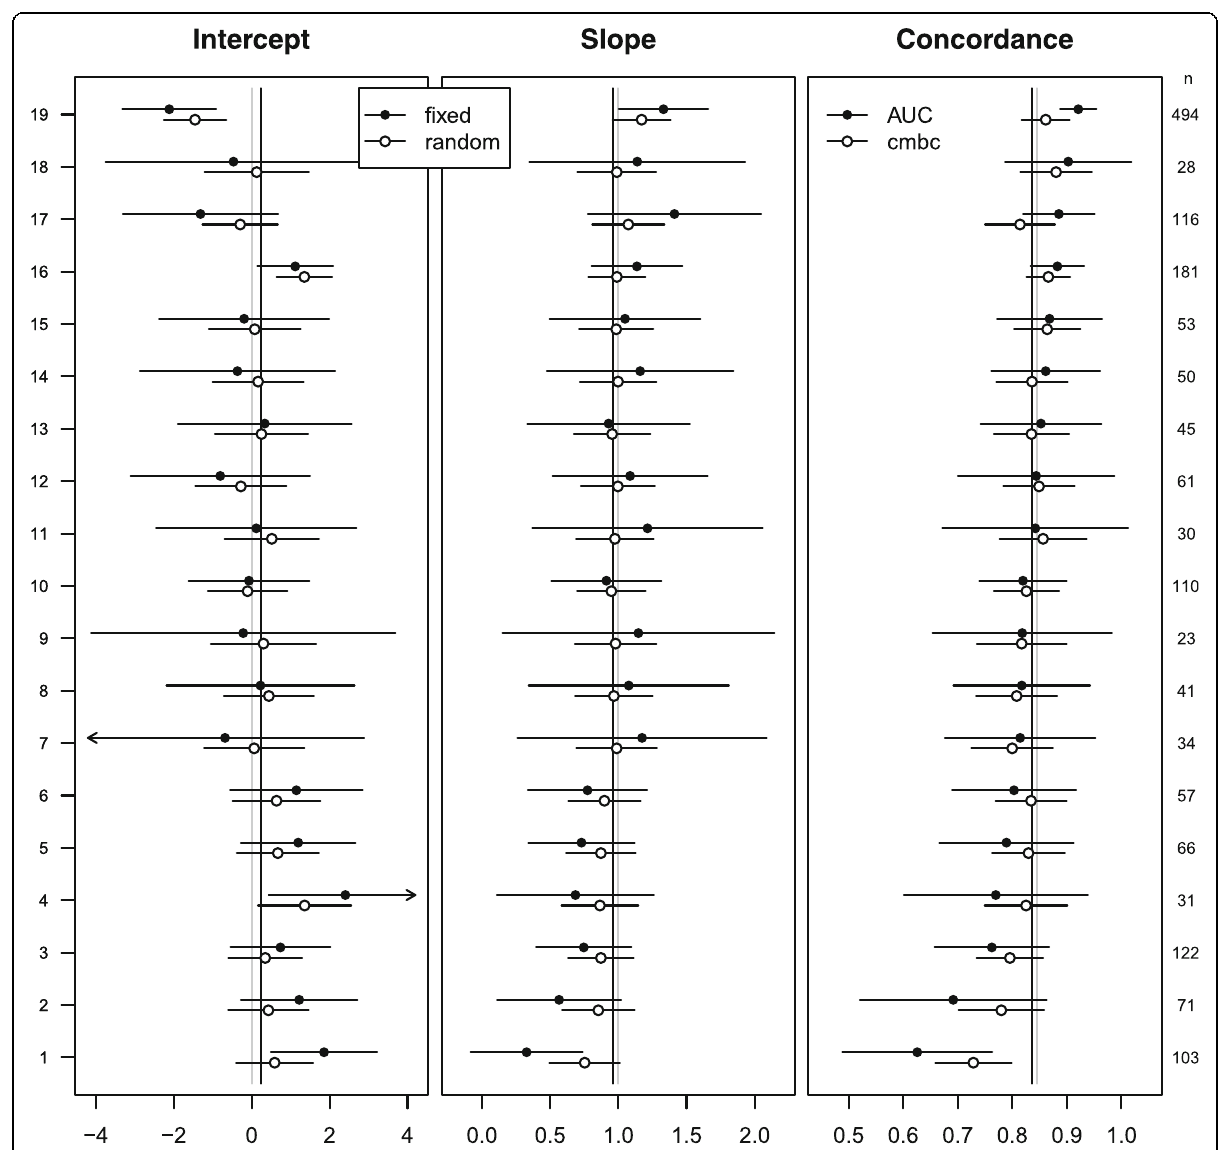
Fig. 1 Performance measures at internal validation across 19 centers of the CRASH trial. Closed dots represent fixed effect intercept estimates; fixed effect slope estimates; and c-indexes in the first, second, and third panel, respectively. Open dots represent random effects intercept estimates, random effects slope estimates, and calibrated model-based concordance estimates in the first, second, and third panel, respectively. Gray vertical lines represent effect estimates of intercept (0) and slope (1) in the original regression model, together with the expected pooled concordance (0.85). Black vertical lines represent fixed effect estimates of intercept (0.24) and slope (0.96) in a multilevel regression model, together with the expected pooled concordance (0.84). The number of patients in each center is indicated on the right y